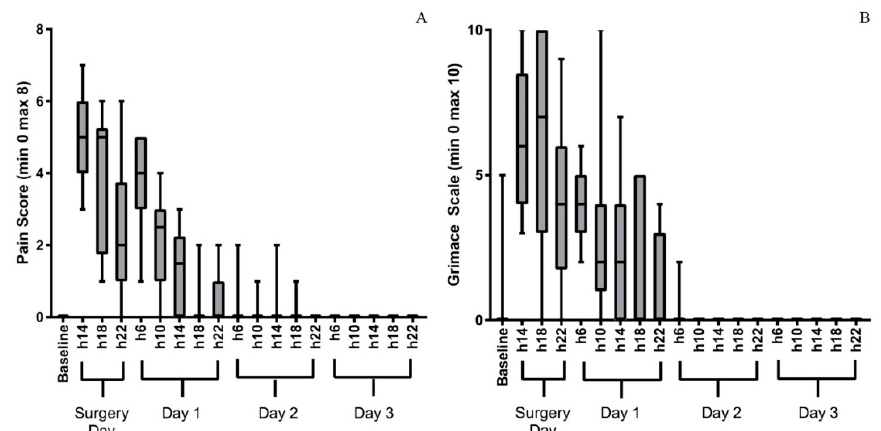
Figure 1. Evolution of composite pain scores ( A ) and the grimace scale ( B ) of 14 rabbits undergoing surgical creation of critical-sized defects in the calvarial bone assessed by one of three trained operators at baseline, on the day of surgery and for 3 days after intervention at 06:00 am, 10:00 am, 14:00, 18:00 and 22:00. Minimum composite pain score is 0, maximum is 8; lowest grimace score is 0, maximum is 10. The boxes represent the values from the lower to the upper quartile, the ends of the whiskers the minimum and maximum values. The median values are represented by the lines in the boxes.